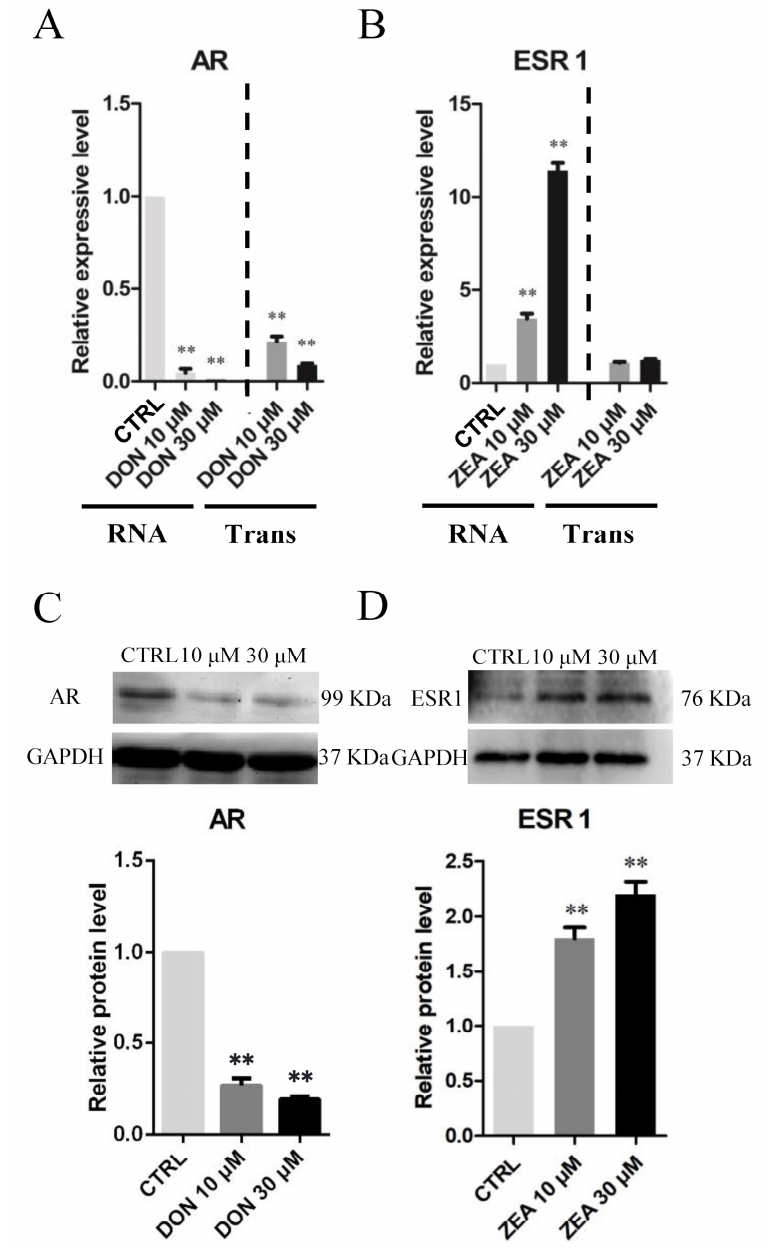
Figure 11. DON and ZEA exposure affects the mRNA and protein abundance of endocrine-related genes in cultured Equus asinus SCs. ( A ) Quantitative RT-PCR for the AR transcription factors. ( B ) Quantitative RT-PCR for the ESR transcription factors. The mRNA levels of the genes were normalised to the GAPDH gene. ( C ) Protein levels of AR / GAPDH by Western blot. ( D ) Protein levels of ESR / GAPDH by Western blot. The protein levels were normalised to GAPDH . The exposure time was 50 s. The results are presented as the means ± SD. All experiments were repeated at least three times. ** p < 0.01.